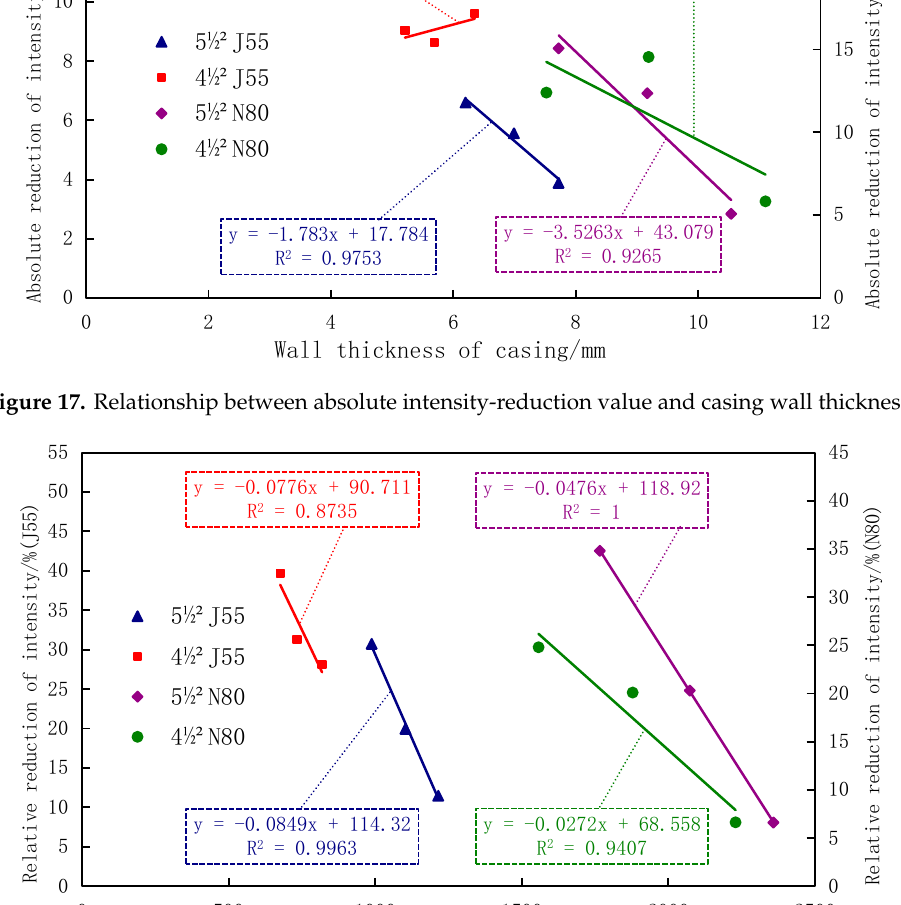
Figure 19. Relationship curve between absolute intensity-reduction value and yield stress.